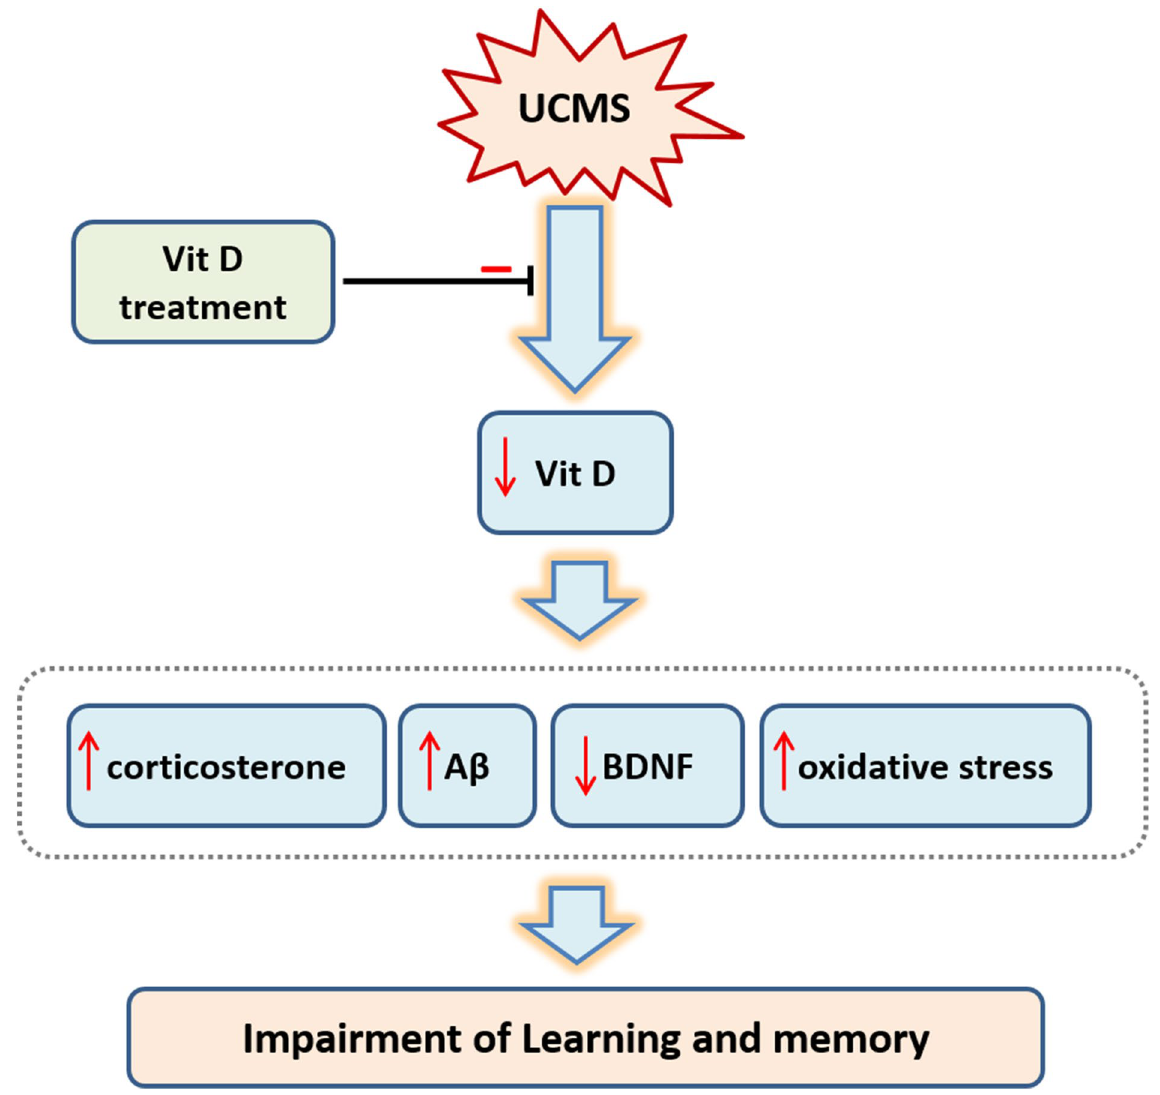
Figure 11. Hypothetical model indicating several machanisms through wich UCMS causes impairment of learining and memory and the protective effect of Vit D treatment. As indicated, UCMS causes Vit D deficiency which in turn leads to the following changes in: increased level of corticosterone, Aβ and oxidative stress markers, as well as reduced level of BDNF. In addition, Vit D treatment can prevent the mentioned UCMS- induced adverse